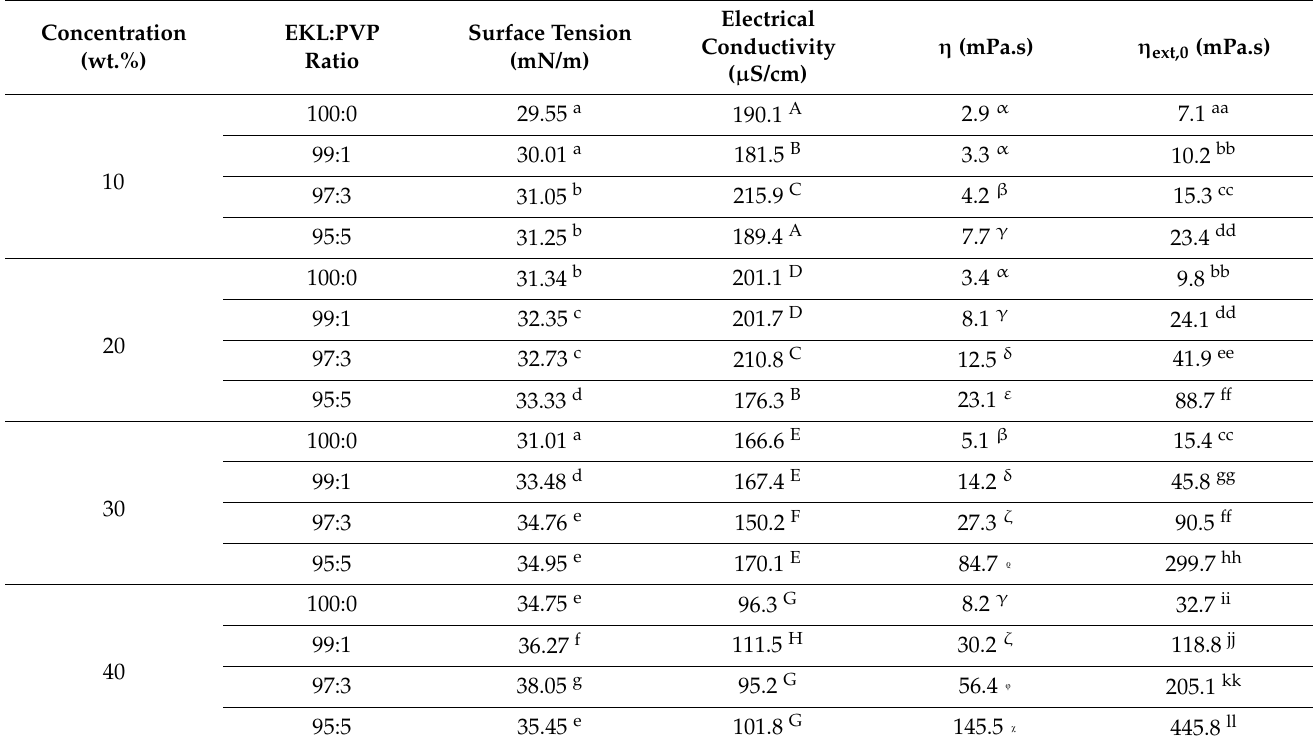
Table 2. Surface tension, electrical conductivity and shear and extensional viscosity for EKL:PVP solutions in DMF. Values with different symbols are significantly different ( p < 0.05). Concentration (wt.%)